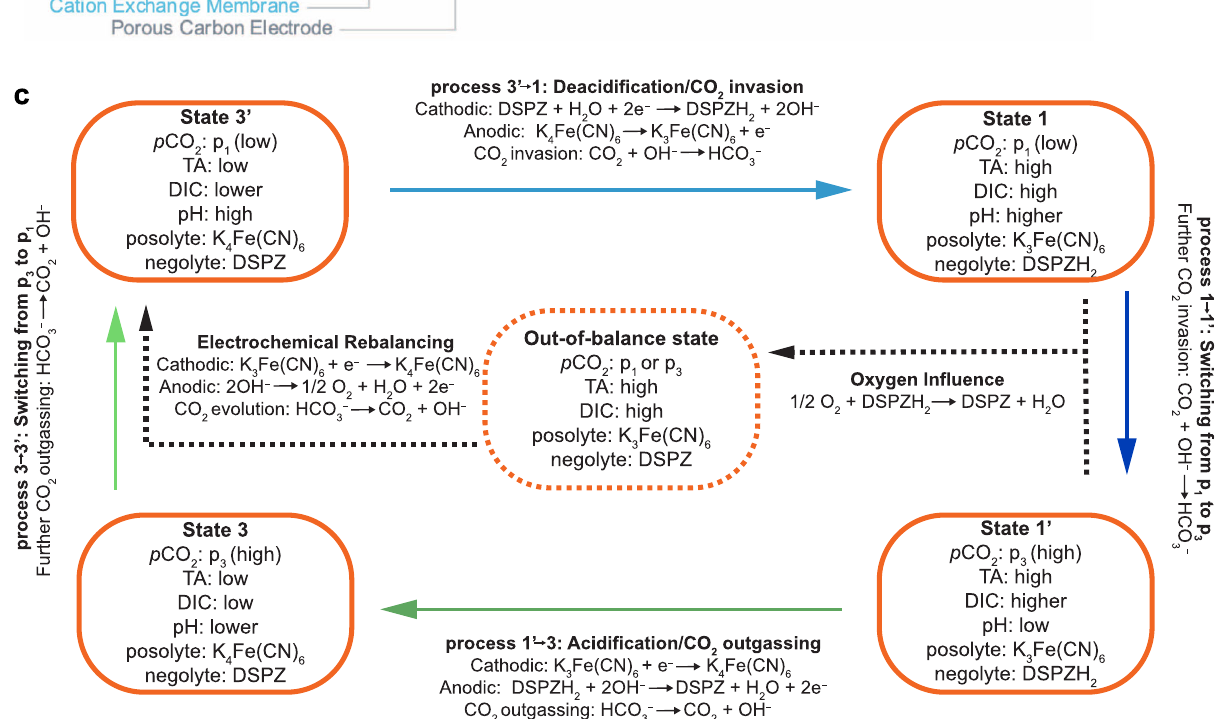
Fig. 1 Scheme of the pH swing carbon capture fl ow system. a Schematic of the reversible PCET (proton-coupled electron transfer) reaction underwent by DSPZ (sodium (3,3 ′ -(phenazine-2,3-diylbis(oxy))bis(propane-1-sulfonate))) in an aqueous solution. b Schematic of the Fe(CN) 6 (posolyte) | DSPZ (negolyte) fl ow cell and full system. Blue arrows indicate gas fl ow direction. Adapted from ref. 18 . c Process fl ow. TA is total alkalinity and DIC is dissolved inorganic carbon. The solid arrows refer to desired reactions in a complete carbon capture/release cycle. The carbonate formation and decomposition reactions are neglected for simplicity. The dashed arrow on the right side refers to the side reaction caused by oxygen and the dashed arrow on the left refers to reactions in the electrochemical rebalancing